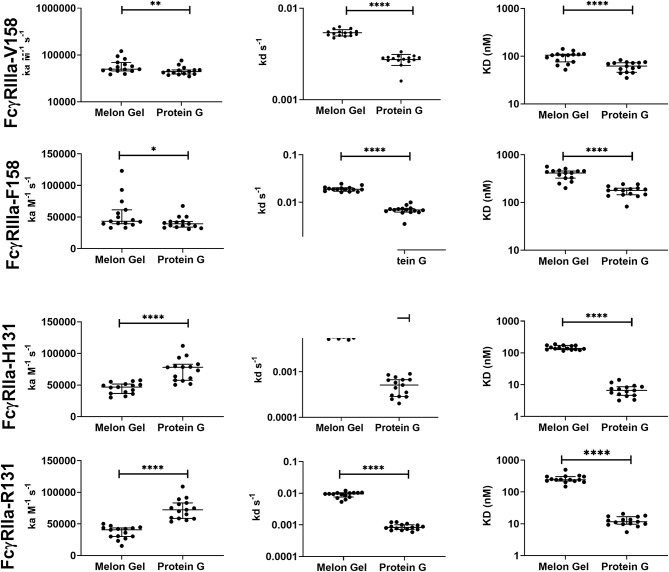
Kinetic constants (median + IQR) of a subset of n = 15 samples of polyclonal IgG purified from plasma either via Melon gel or Protein G immunochromatography. Kinetic constants were obtained by data globally fitted to a 1:1 interaction model. *p ≤ 0.05; **p ≤ 0.01; ****p ≤ 0.0001.